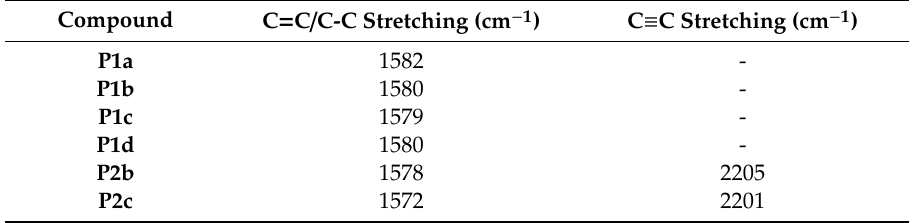
Table 3. Experimental Raman data for P1 – P2